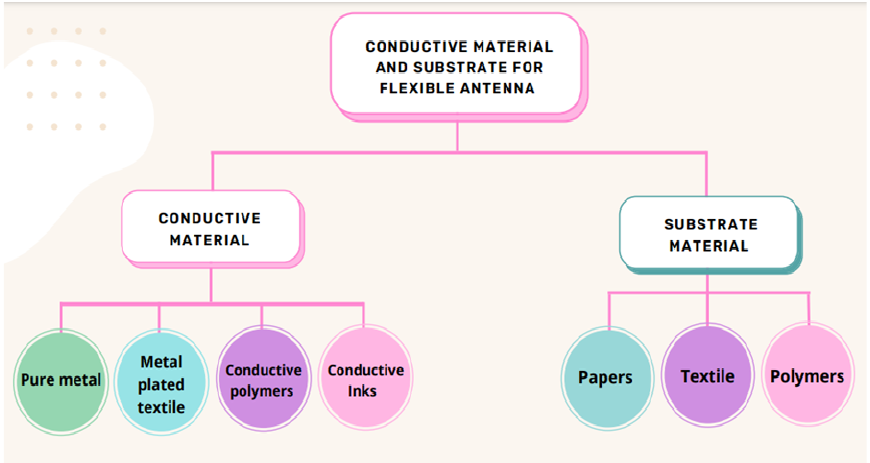
Figure 5 . Materials for flexible antenna